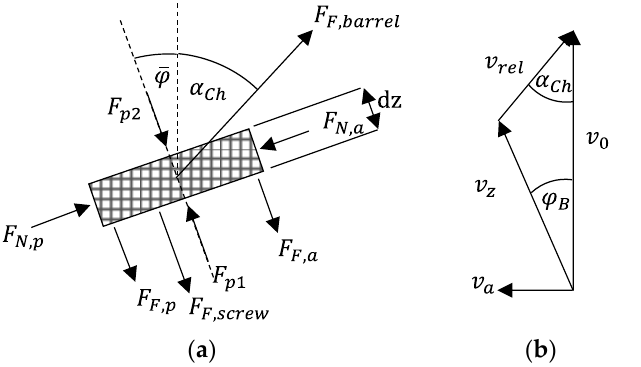
Figure 2. ( a ) Forces acting on solid bed; ( b ) balance and analysis of velocities in the screw channel.